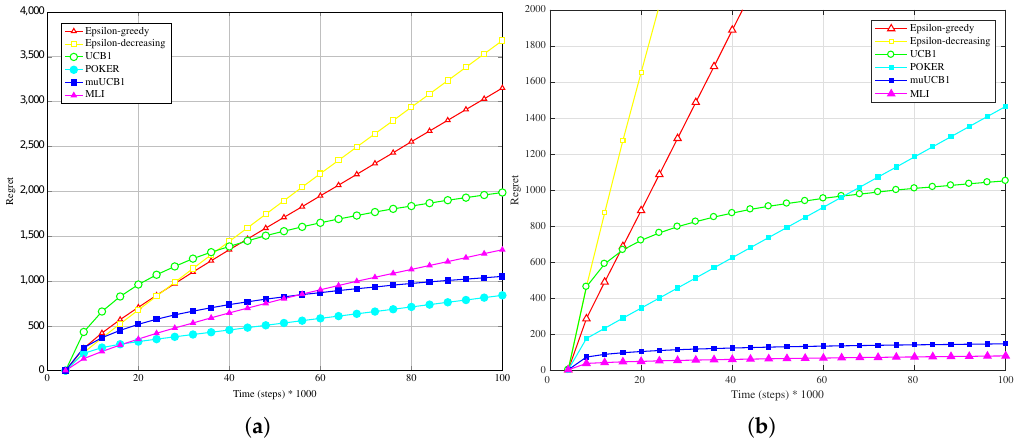
Figure 3. Performance in terms of regret of the six considered algorithms, with a Bernoulli distribution for the reward PDF and T U / T M = 10. ( a ) Hard configuration; ( b ) Easy configuration.